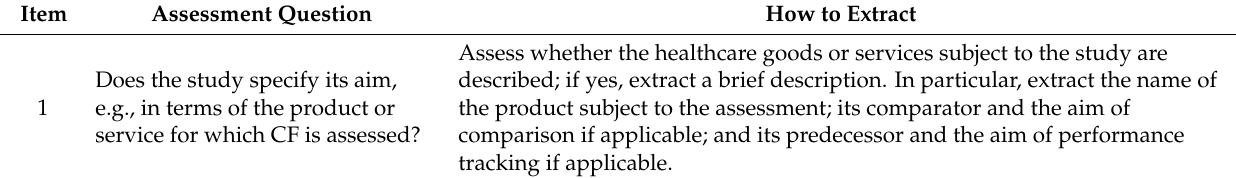
Table 1. Methodological items of carbon footprint analyses.